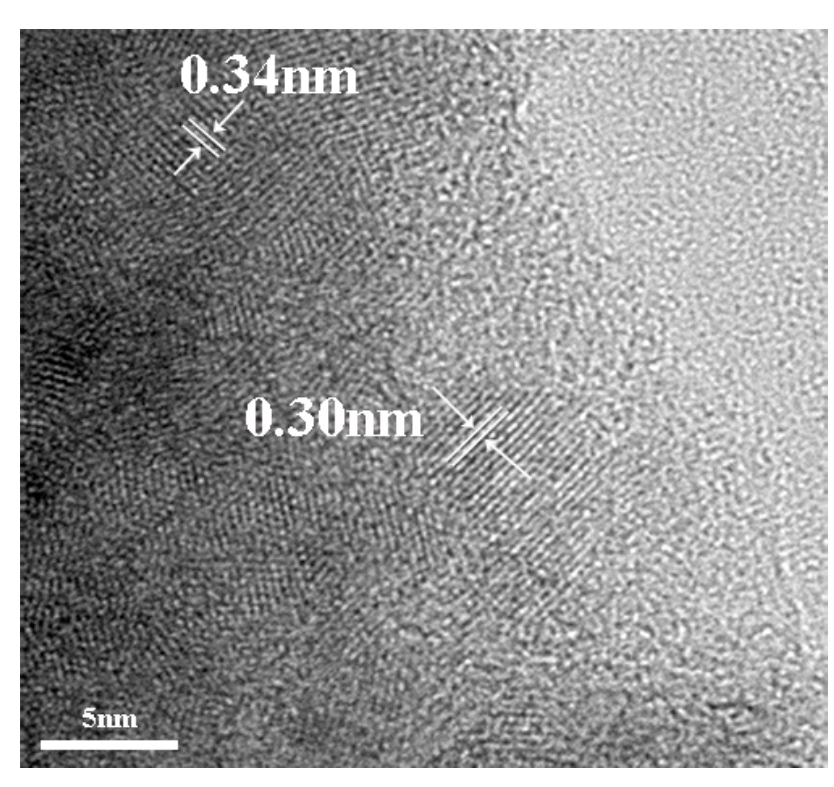
Figure 3. TEM image of Al-ZG.